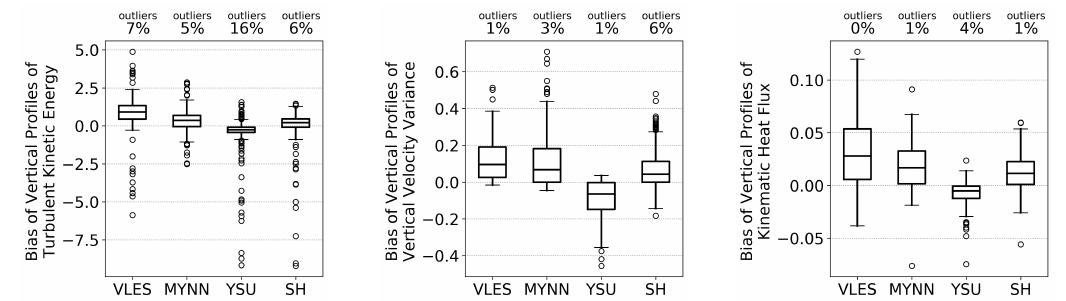
Figure 9. Distribution of bias time series computed from vertical profiles of horizontally averaged turbulent kinetic energy, vertical velocity variance and heat flux. Whisker plots show 25th, 50th and 75th quantiles. The circles extending out from the whisker plots represent the distribution outliers. The percent values in each figure quantify the percentage of outliers rounded to the nearest integer.